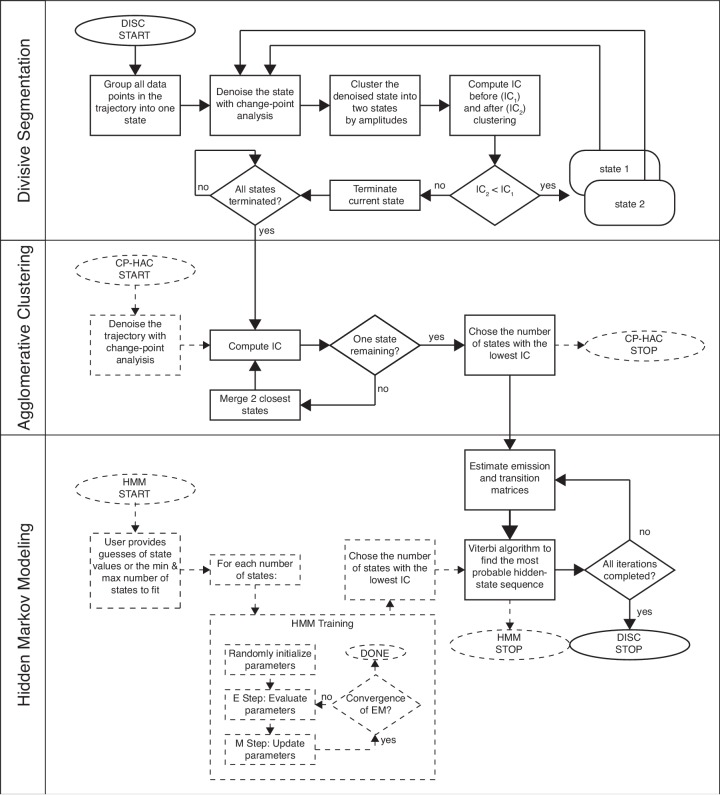
Workflow of DISC.Solid lines indicate the path DISC takes through divisive segmentation, hierarchical agglomerative clustering, and the Viterbi algorithm. IC = information criterion. General CP-HAC and HMM approaches are shown for comparison. Dotted lines indicate steps that do not overlap with DISC. Ovals indicate start/stop; rectangles indicate a process or computation; diamonds represent decisions. Note, most current uses of HMMs involve a single user-defined number of states.